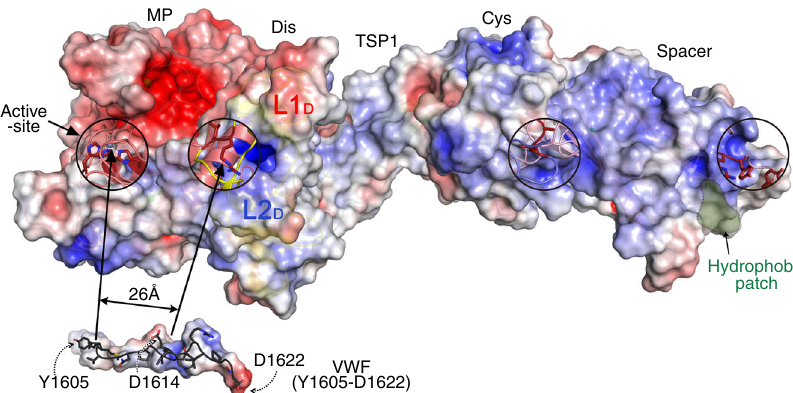
Fig. 6 Electrostatic potential at the molecular surface of ADAMTS13 MDTCS (MP through to Spacer). The charged surface representation of MDTCS is presented in the “ front ” view as in Fig. 4 b (negative charges — red; positive charges — blue). Domains are labelled above. The active-site and the disintegrin- like (Dis), cysteine (Cys)-rich and Spacer domain exosites are circled. The L1 D loop in the Dis domain that was not fully resolved in the DTCS structure is highlighted, and also the L2 D loop. Together, these loops provide the interaction site for reciprocally charged Von Willebrand factor (VWF) residues 1615 – 1622. The peptide Tyr 1605 -Asp 1622 is shown. The distance from the metalloprotease (MP) domain active-site to Arg 349 in the Dis domain is 26 Å, which matches the distance from the Tyr 1605 -Met 1606 scissile bond to Asp 1614 that interacts with Arg 349 . The Spacer domain exosite involving Arg 660 , Tyr 661 , and Tyr 665 has been reported to interact with the C-terminal CUB domains of ADAMTS13. We propose that the Spacer domain makes a hydrophobic interaction with Leu 1664 , Val 1665 , and Leu 1666 with an adjacent surface hydrophobic patch (green) centered around Ile